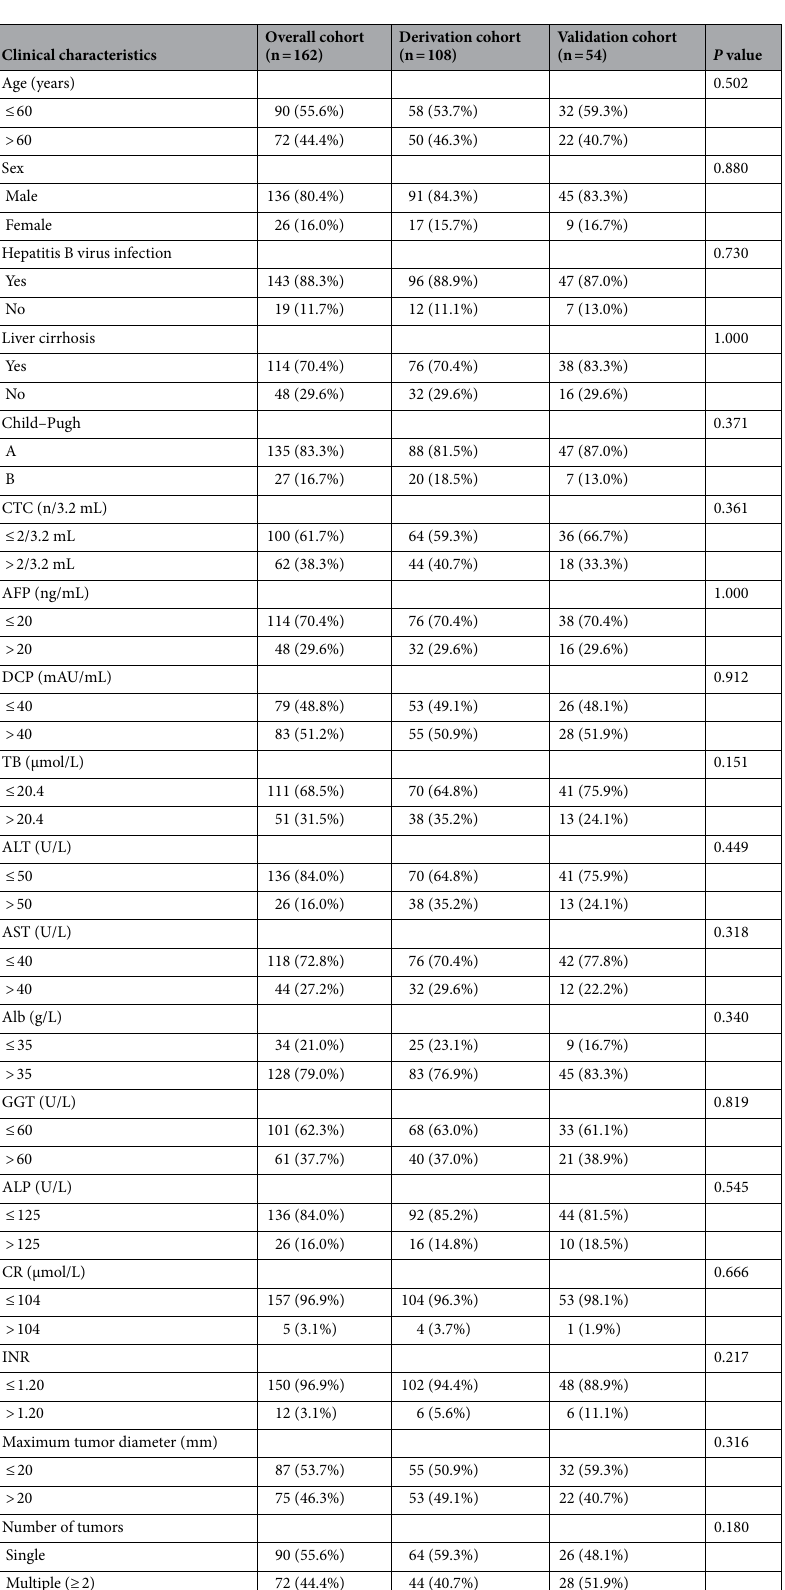
Table 1. Clinical characteristics of derivation cohort and validation. CTC, Circulating tumor cell; AFP, Alpha- fetoprotein; DCP, Des-γ-carboxy prothrombin; TB, Total bilirubin; ALT, Alanine aminotransferase; AST, Aspartate aminotransferase; Alb, Albumin; GGT, Gamma-glutamyltransferase; ALP, Alkaline phosphatase; CR, Creatinine; INR, International normalized